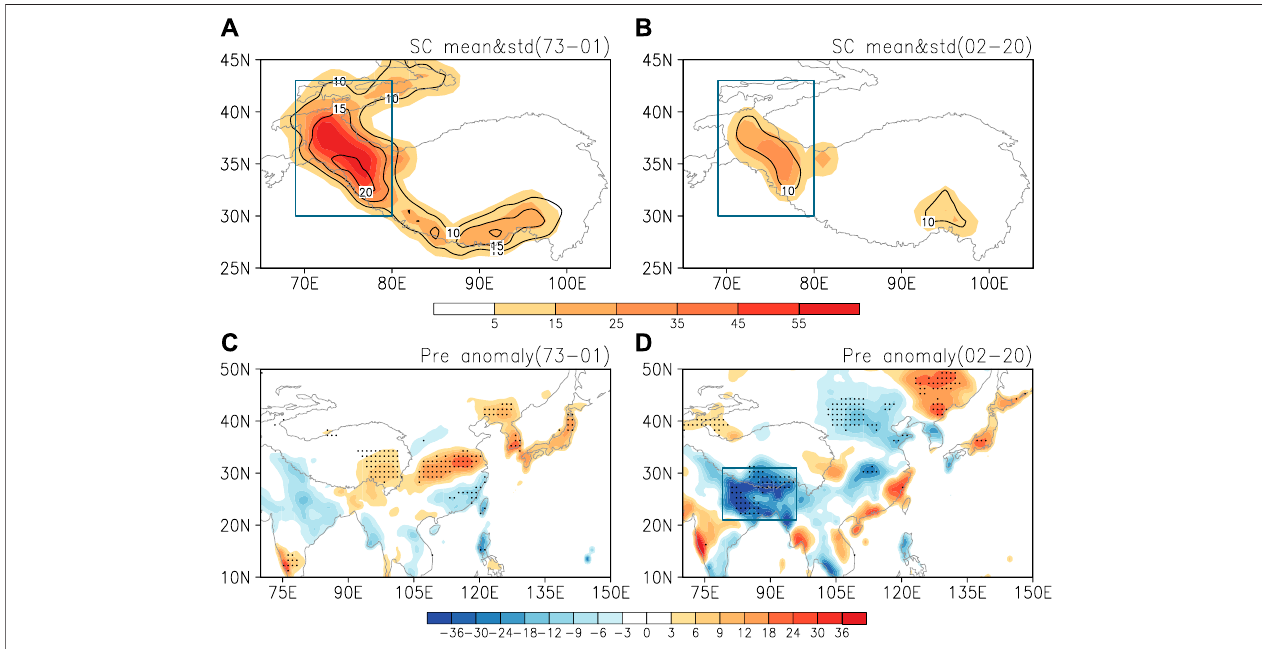
FIGURE 2 | Climatological mean (shading, %) and interannual standard deviation (contour, %) of snow cover over the Tibetan Plateau for the period (A) 1973 — 2001 and (B) 2002 — 2020. Anomalies of summer precipitation (Pre) (mm/month) obtained by linear regression against the western Tibetan Plateau summer snow cover index for the period (A) 1973 — 2001 and (B) 2002 — 2020. The dotted regions in (C) and (D) denote anomalies signi fi cant at the 95% con fi dence level. The box covered area in (D) denotes the domain (21 ° N-31 ° N, 79 ° E-96 ° E) of northeast Indian region.